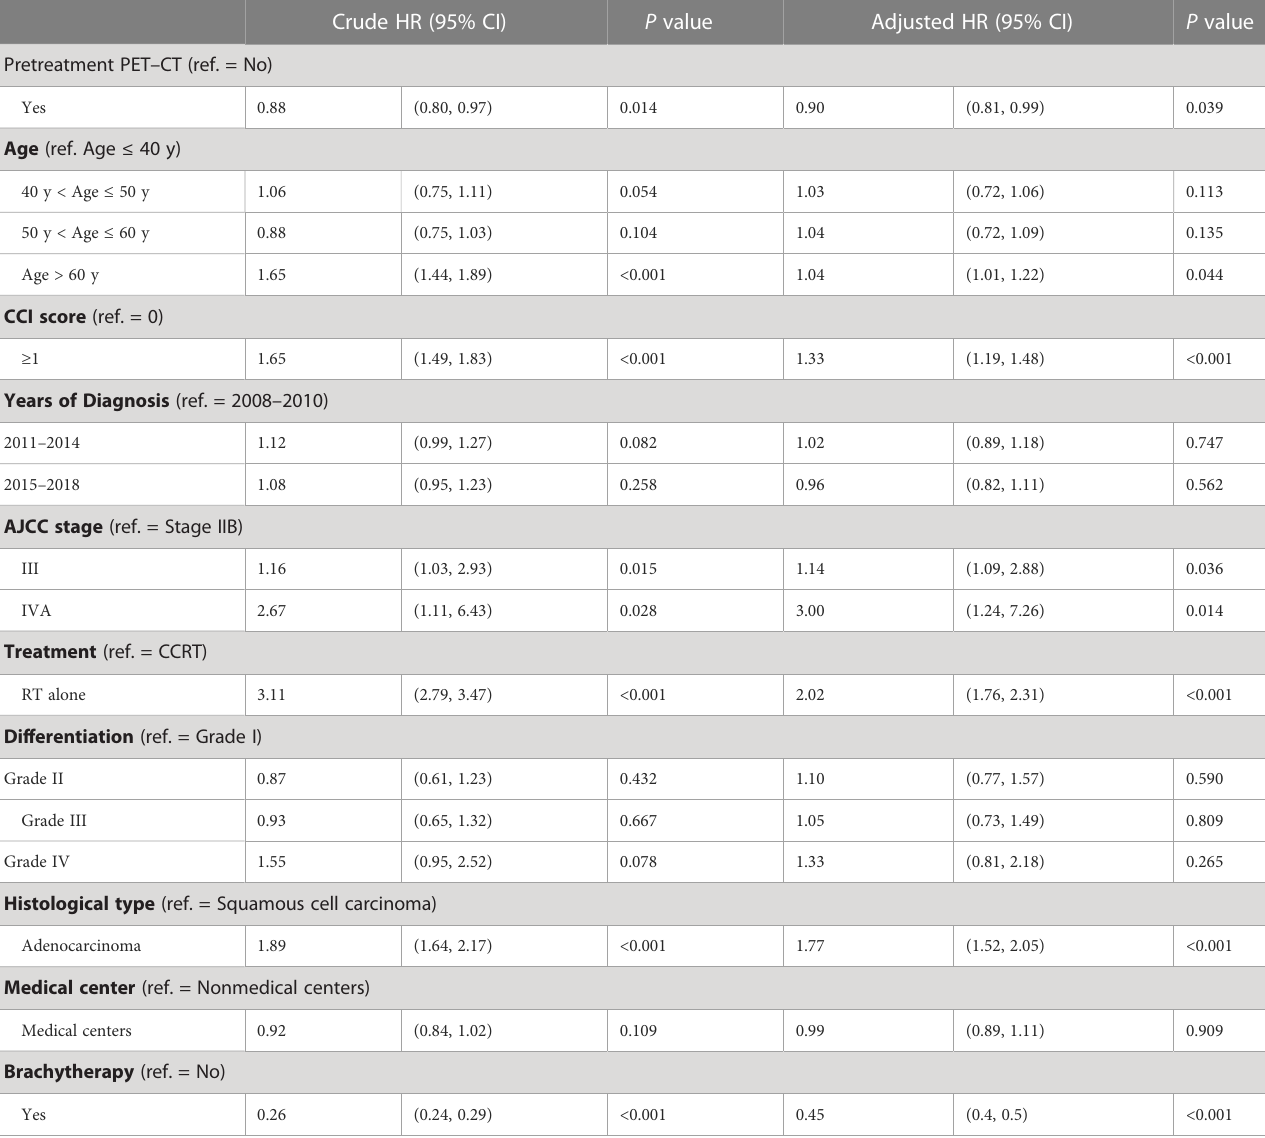
TABLE 4 Cox proportional hazard regression analysis of the risk of all-cause death in propensity score – matched patients with AJCC stage IIB – IVA cervical